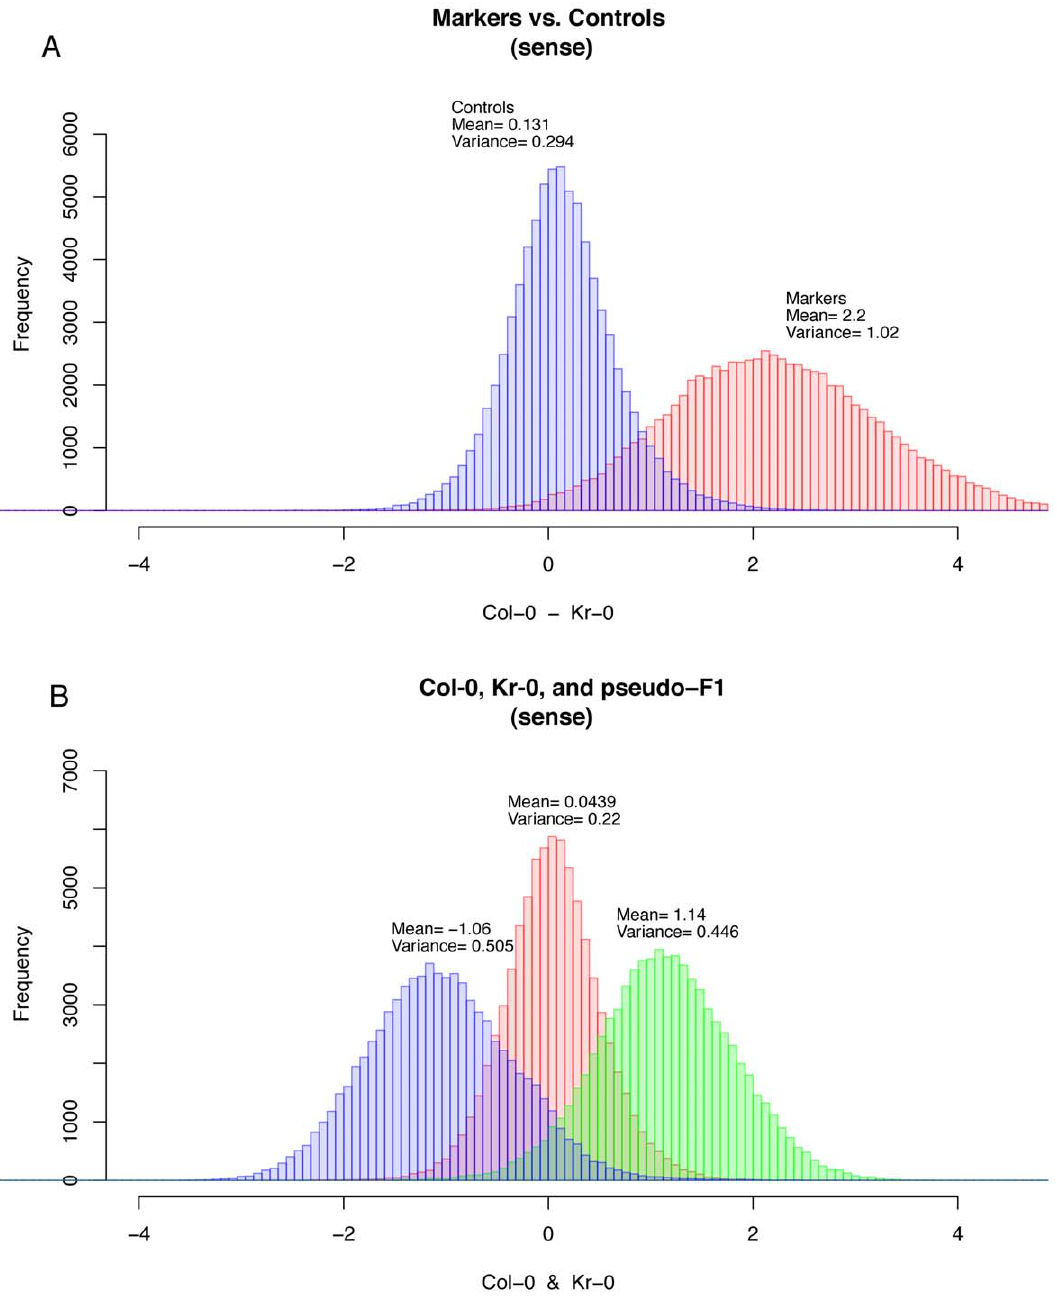
Figure 1. Probe signal distributions. (Top) Histograms of the difference in allele signals (Col-0 allele probe – other allele probe) of sense strand signals between the Col-0 and Kr-0 parent arrays for probe sets marked by the Atwell et al. [12] as polymorphic (markers) and not marked as polymorphic (controls). (Bottom) Histograms of the allele signals from the parent arrays and the pseudo-F 1 array constructed from the mean of the parent arrays. The pseudo-F 1 array signals are distributed about zero, as would be expected for an actual heterozygous plant.